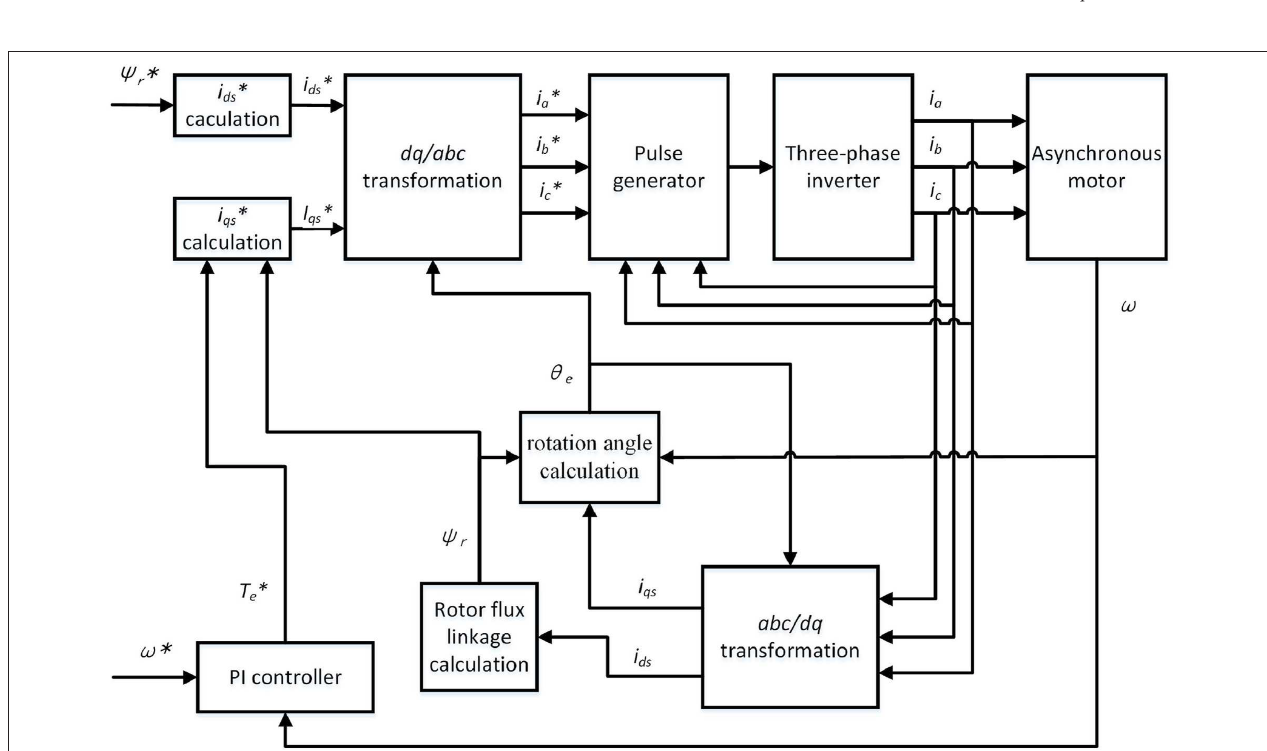
FIGURE 11 | Control strategy for a single